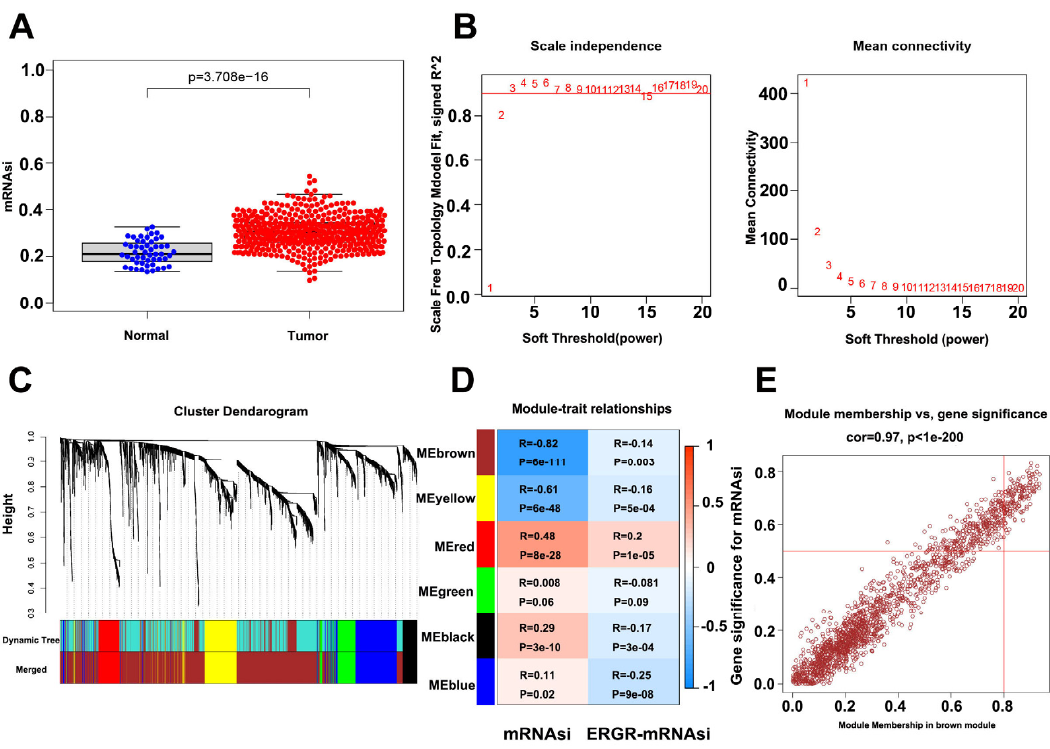
Figure 1. Identification of PCSC-associated genes. ( A ) Box plot showing mRNAsi scoring in tumor samples vs normal samples. ( B ) Optimal soft threshold settings. ( C ) Clustering dendrogram of 499 TCGA-PRAD samples. ( D ) Correlation index of each module with mRNAsi vs. EREG-mRNAsi. ( E ) Correlation index of genes in the brown module.